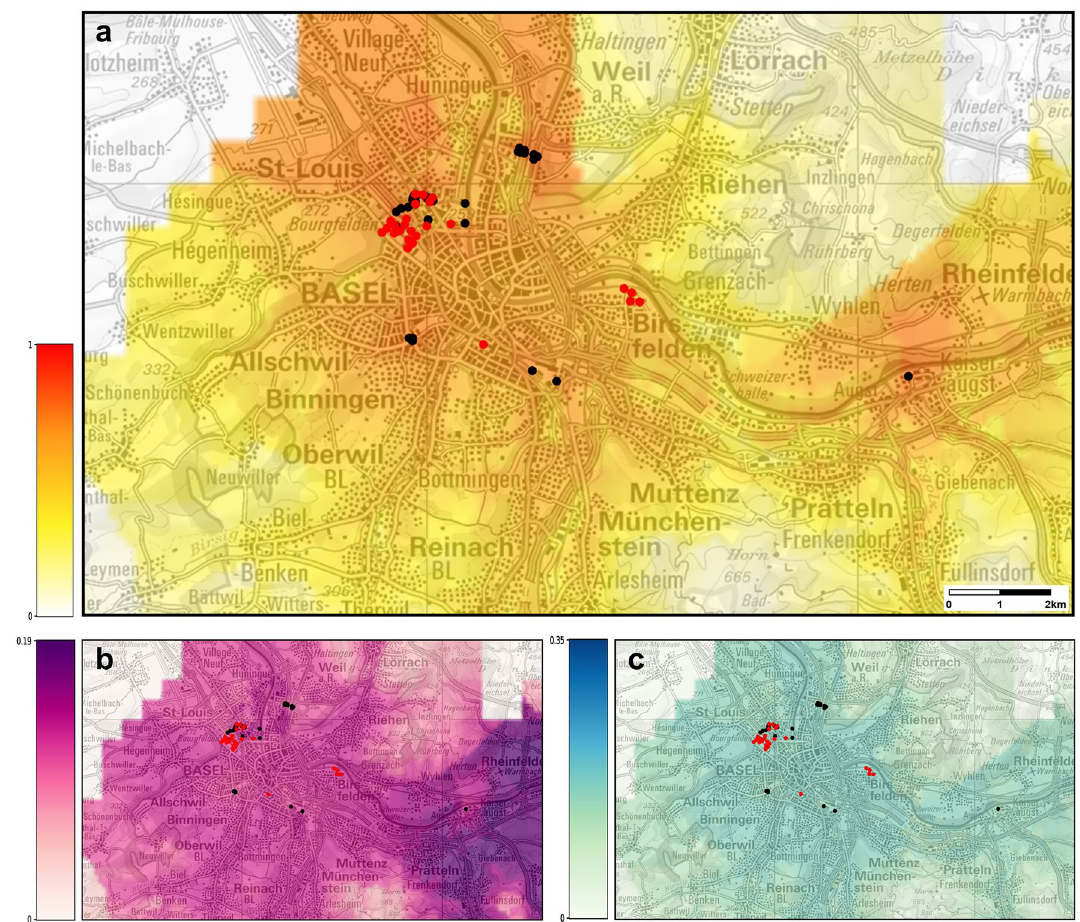
Figure 5. ( a ) Probabilities of establishment of Ae. albopictus in Basel using the temperatures corrected with the microclimatic model. The map shows the average risk estimate over the years 2015–2018. The color gradient shows the probability of establishment from 0 (white) to 1 (red). ( b ) Uncertainty of prediction (higher values representing more uncertain predictions). ( c ) The difference between the risk estimates obtained using the original temperatures and the transformed ones. Black and red dots: ovitraps with observation and establishment of Ae. albopictus in 2019 and 2021, respectively. Maps modified from https:// map. geoad min. ch/ (accessed on 1 April